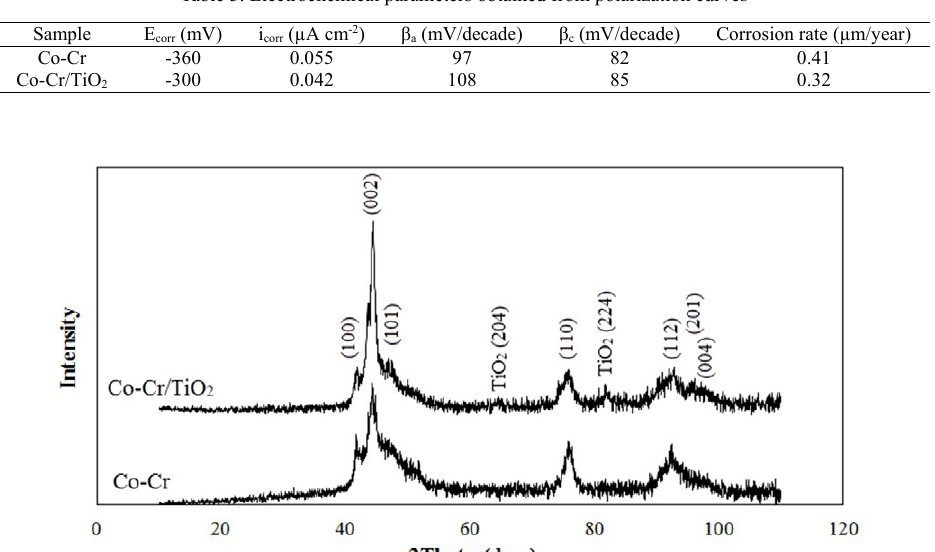
Fig. 3. XRD patterns of Co-Cr and Co-Cr/TiO 2 coatings.